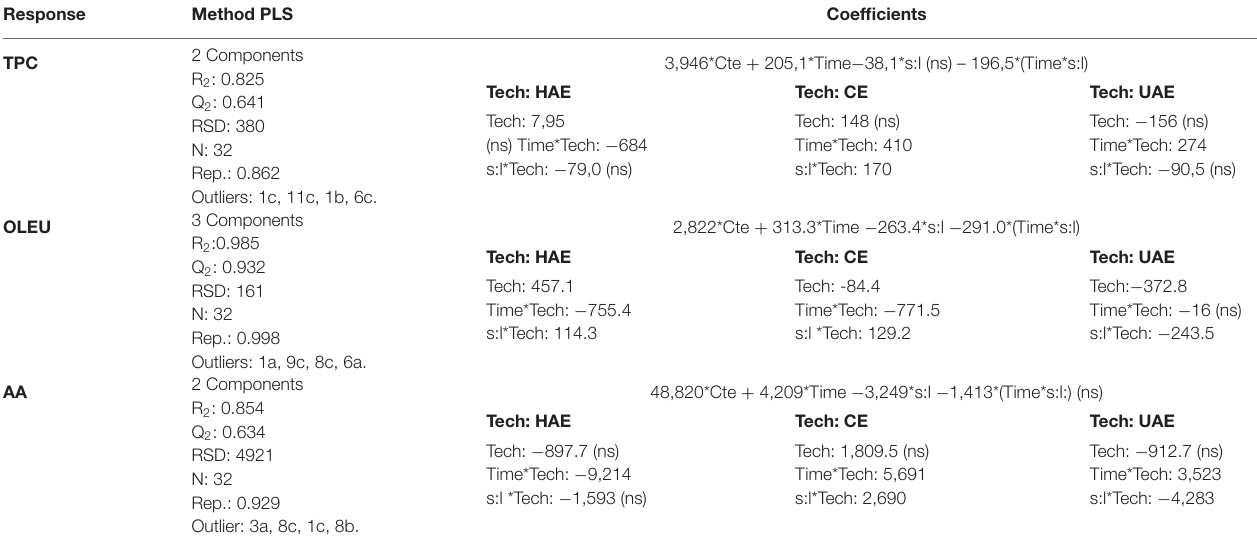
TABLE 2 | DOE’s to evaluate the effect of time, s:l ratio, and extraction technique on the responses TPC, OLEU concentration, and AA by DPPH assay.